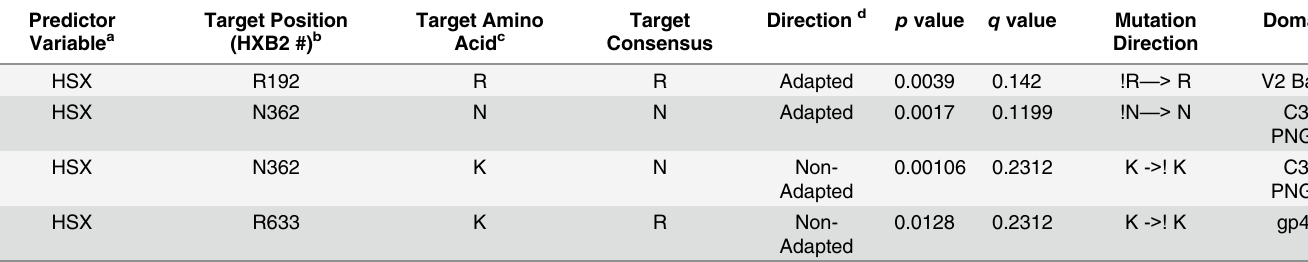
Table 2. Previously described signature sites enriched in HSX Founder viruses. Predictor Variable